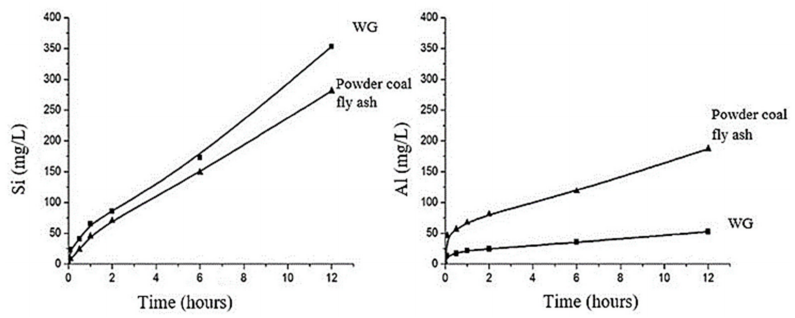
Figure 18. Si and Al dissolution from WG powder and fly ash [64].